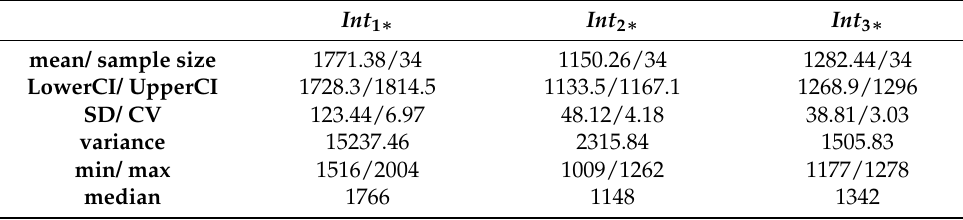
Table 6. Results of the Int 1 ∗ , Int 2 ∗ , Int 3 ∗ analysis.